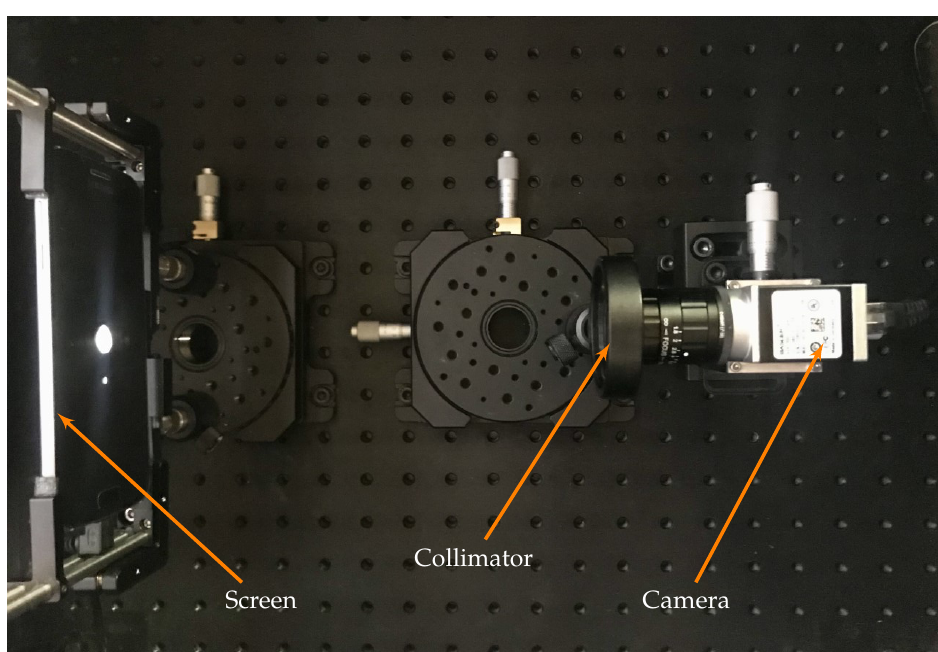
Figure 3. CAD model of TinyV3RSE.